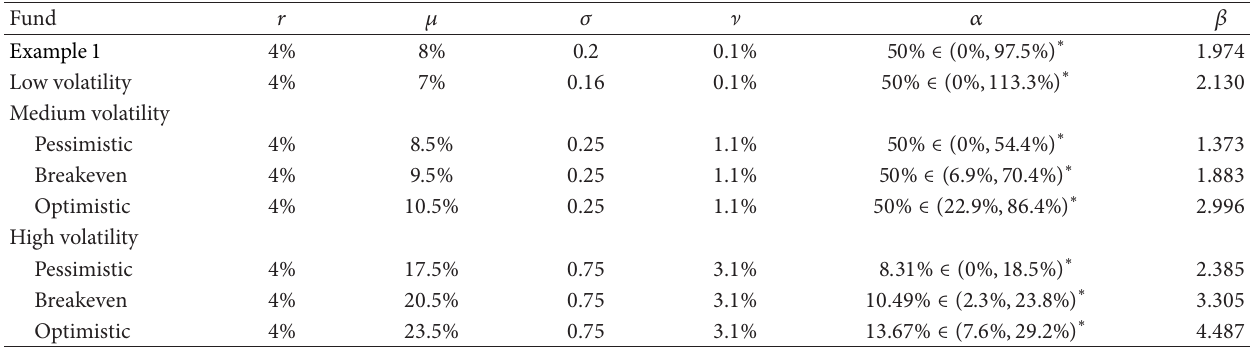
Table 1: Opportunity cost of administrative costs ( 𝛽 ) for selected combinations of parameter values ( 𝛾 = 10 %, 𝑡 = 40 ). Fund